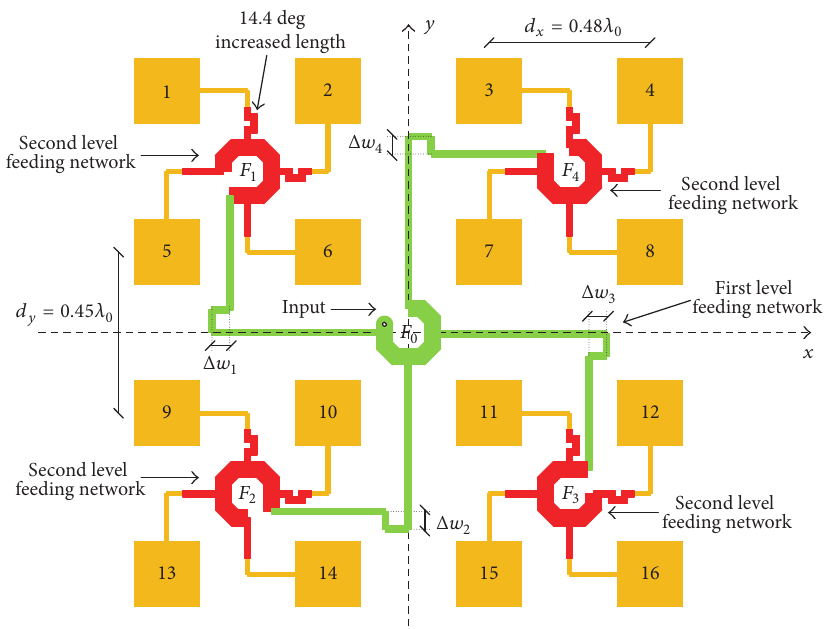
Figure 5: 4 × 4 antenna array design scheme.